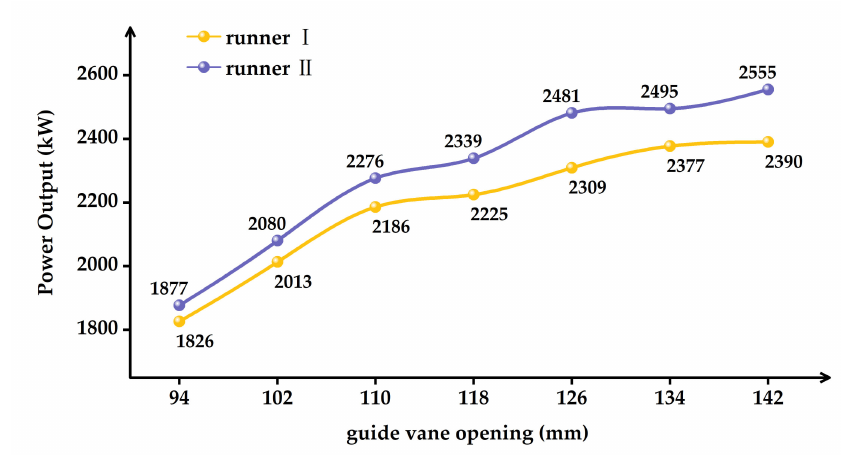
Figure 9. Relationship curve between output and guide vane